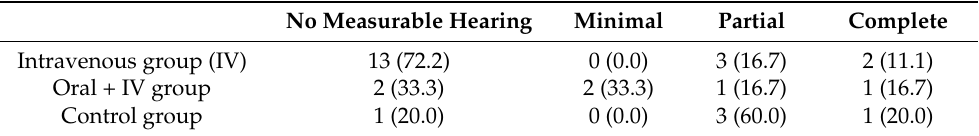
Table 4. Hearing preservation 12 months after CI activation, according to treatment